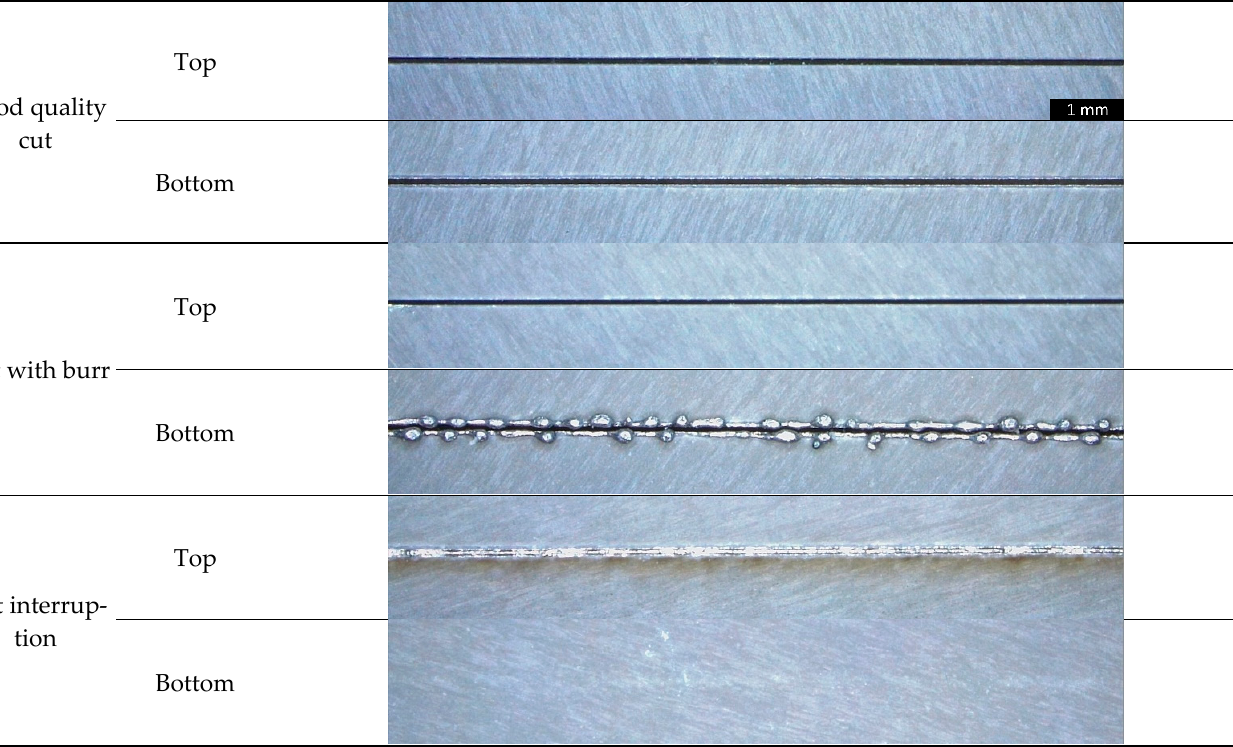
Figure 2. Images of the top and bottom side of laser cuts with and without cut errors taken with an optical microscope after laser cutting.